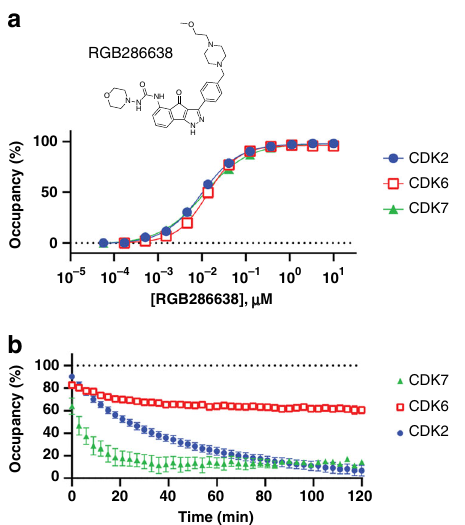
Fig. 5 Pan-CDK inhibitor RGB286638 is kinetically-selective for CDK6 over CDK2/7 in cells. a Compound structure and steady-state target engagement of RGB286638 for CDKs 2, 6, and 7. A representative single technical replicate ( n = 1) from 3 independent experiments is shown (Supplementary Data 2). b Residence time was measured by pretreating cells with compound (10 − 20-fold above the apparent K d measured in a ), followed by compound removal and introduction of energy transfer probe 1 at 1 µ M. After 2 h of real-time analysis, CDK6 is >50% occupied while CDK2 and CDK7 are fully dissociated. Apparent residence times were 41 min for CDK2 and 8 min for CDK7, while residence time at CDK6 was too long to quantify after 2 h of analysis. Data are the mean ± S.E.M. of three independent experiments. Source data are provided as a Source Data fi